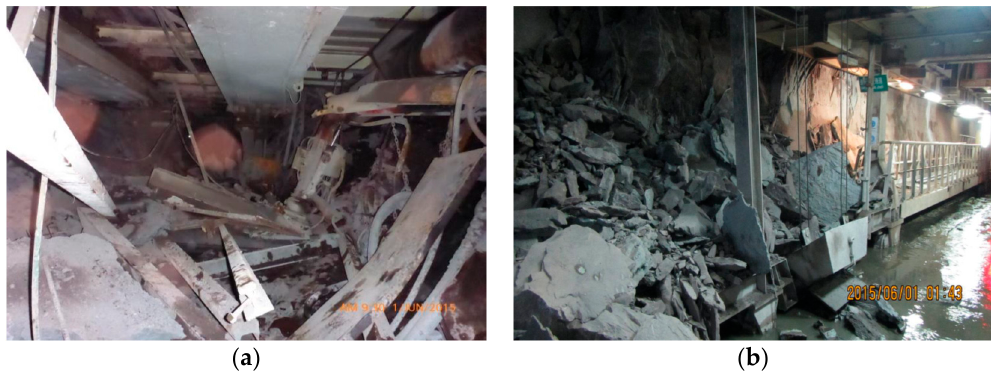
Figure 5. Rockburst damage from the 31 May 2015 event.